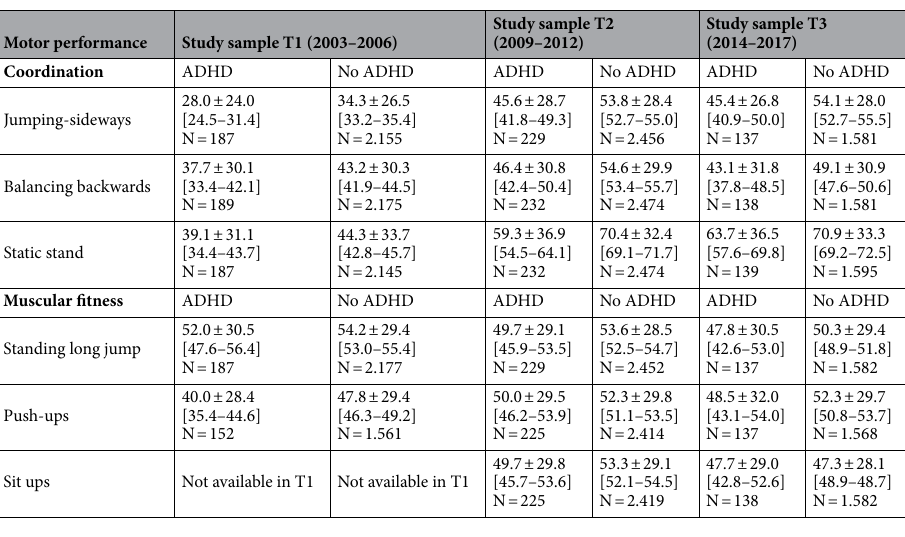
Table 2. Descriptive results of motor performance and ADHD (T1, T2, and T3). Data are the mean values (M) of the percentiles ± standard deviation (SD) and [95% CI = confidence interval]. A percentile value of 1